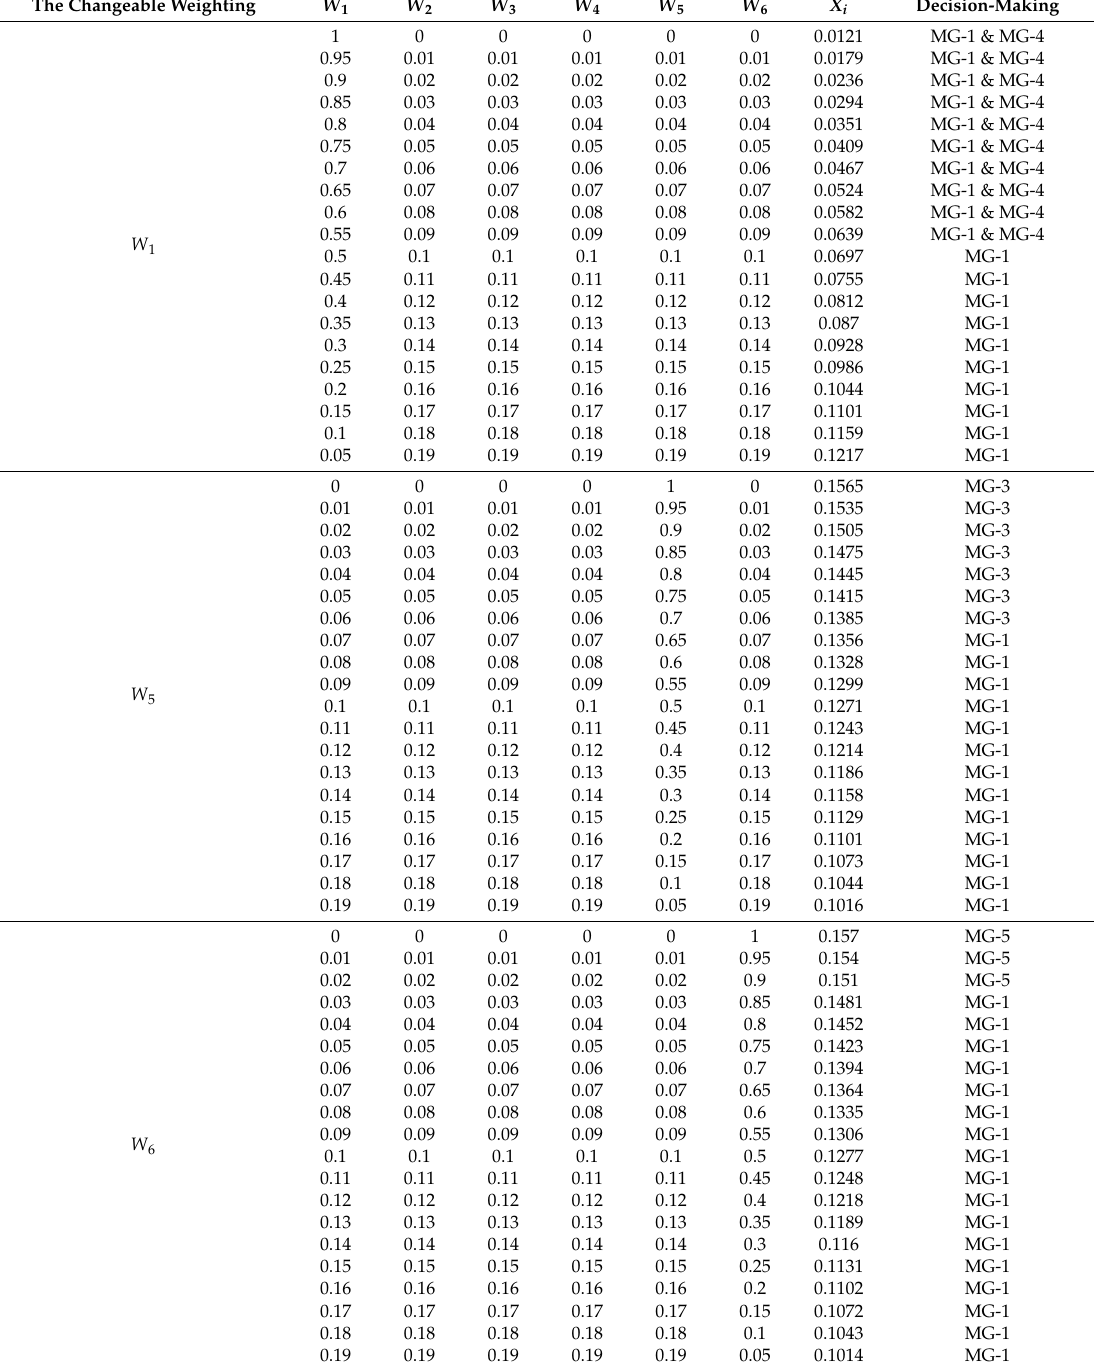
Table A3. Biased weighted index of voltage deviation, electricity price and CO 2 emission indices. The Changeable Weighting